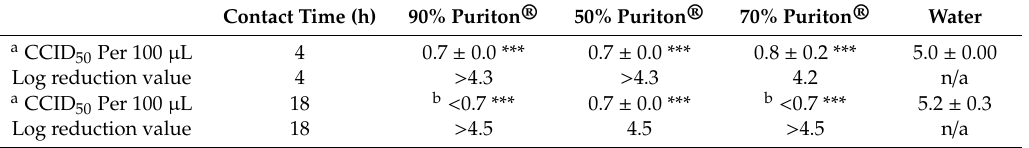
Table 2. Virucidal e ffi cacy of Puriton ® against Zika virus after 4 or 18 h of liquid–liquid contact at 22 ± 2 ◦ C.